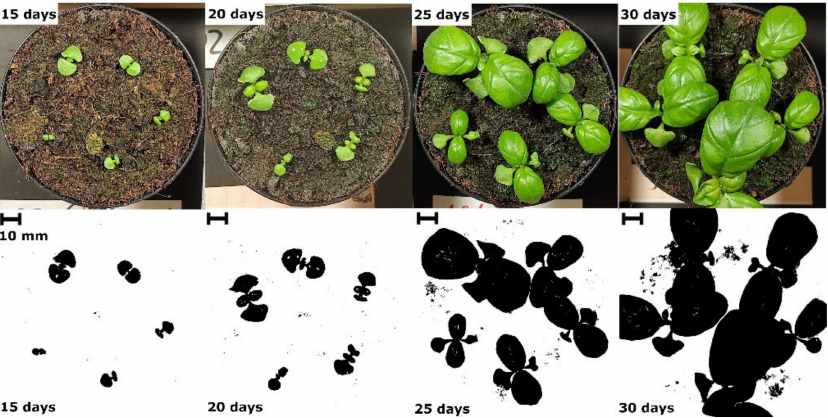
Figure 2. Example of the pictures taken for each pot in different phases of growth (top), and results of the elaboration performed to isolate and measure leaves area for the calculation of LAI